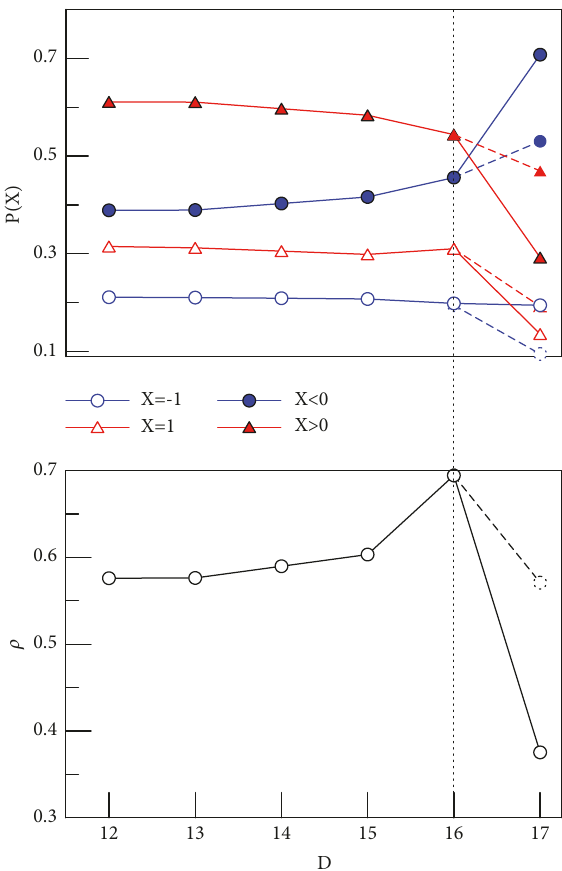
Figure 8: Evolution of the probability distribution of opinions for the values X : -1,+1, > 0, and < 0 (top) and the polarization index, 𝜌 , for the retweet networks starting on December 11th until day D of 2017 Chilean Presidential elections. In dotted line, the values correspondingtotheelectoralcampaignperiod11-17December2017 without taking into account the users who only participated on the voting day.